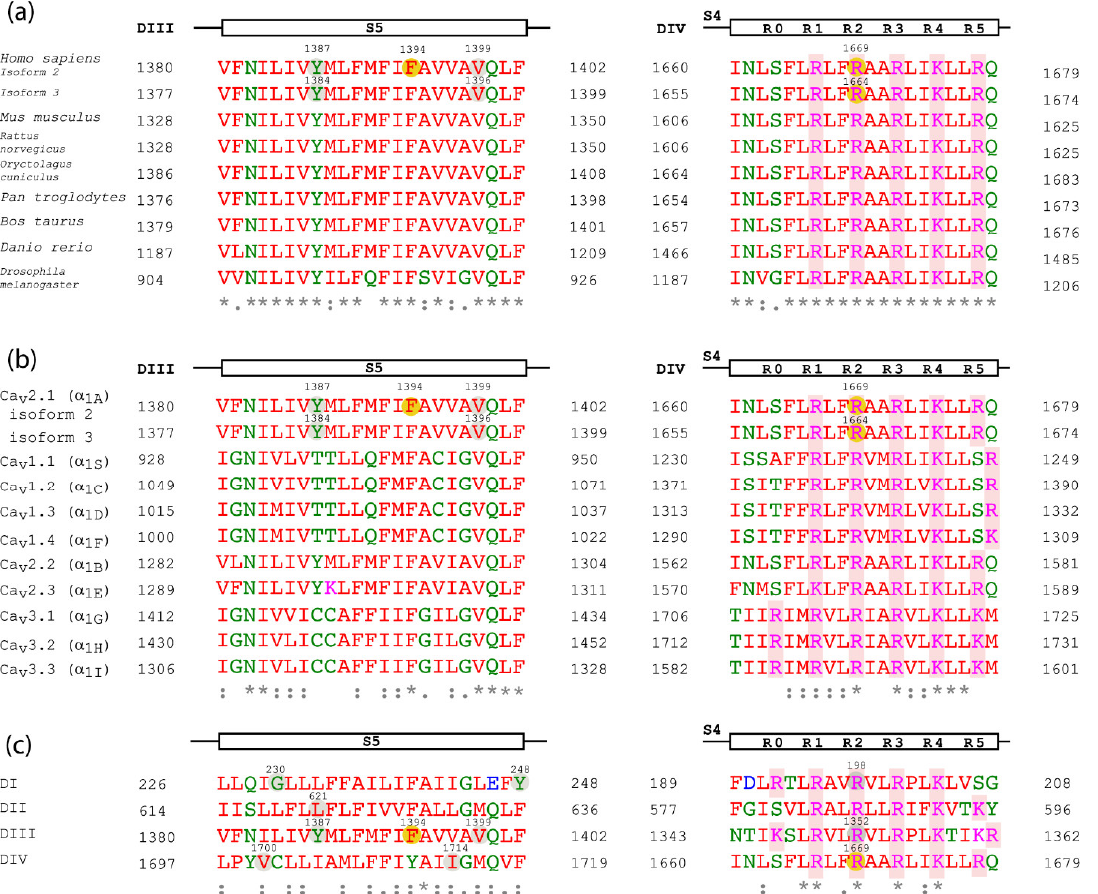
Figure 3. Sequence alignment of the α 1A subunit regions affected by the amino acid variants. Sequence alignment of the α 1A subunit regions affected by mutations, including α 1A isoforms 2 and 3, between different species ( a ), between the human Ca V channel family ( b ) and between the four domains of α 1A subunit isoform 2 ( c ). The α 1A region of each alignment is indicated at the top. Ca V 2.1 mutations are highlighted with yellow circles on the α 1A subunit isoform 2 or 3. Other Ca V 2.1 residues affected by mutations mentioned in the text are indicated in gray circles. The gating charged amino acids of S4 segments (labeled R0-R5) and shaded in red. Residues are colored given their physicochemical properties: small and hydrophobic are in red, acidic in blue, basic in magenta and G and residues containing hydroxyl, sulfhydryl or amine groups in green. The consensus code below indicates fully conserved residues (*), conservative (:) or semi-conservative amino acid substitutions (.). The Uniport IDs of the aligned orthologous Ca V 2.1 sequences are: Mus musculus : P97445; Rattus norvegicus : P54282; Oryctolagus cuniculus : P27884; Pan troglodytes : A0A2I3T217; Bos taurus : F1N1E0; Danio rerio : E9QJF6; Drosophila melanogaster : P91645. The IDs of the human Ca V channel family aligned are the following hCa v 1.1: Q13698; hCa V 1.2: Q13936; hCa V 1.3: Q01668; hCa V 1.4: O60840; hCa V 2.2: Q00975; hCa V 2.3: Q15878; hCa V 3.1: O43497; hCa V 3.2: O95180; hCa V 3.3: Q9P0X4. The sequence alignments were made using Multiple Sequence Aligment Clustal Omega. Here, residue numbers are indicated according to their position in α 1A subunit isoform 2 and 3; however, some of them differ from the nomenclature of the mutations found in the literature: R1350Q/R1349Q corresponds to R1352Q in isoform 2, Y1385C to Y1387C in isoform 2 and Y1384C in isoform 3, V1396M is V1399M in isoform 2 and V1695I is V1700I in isoform 2.